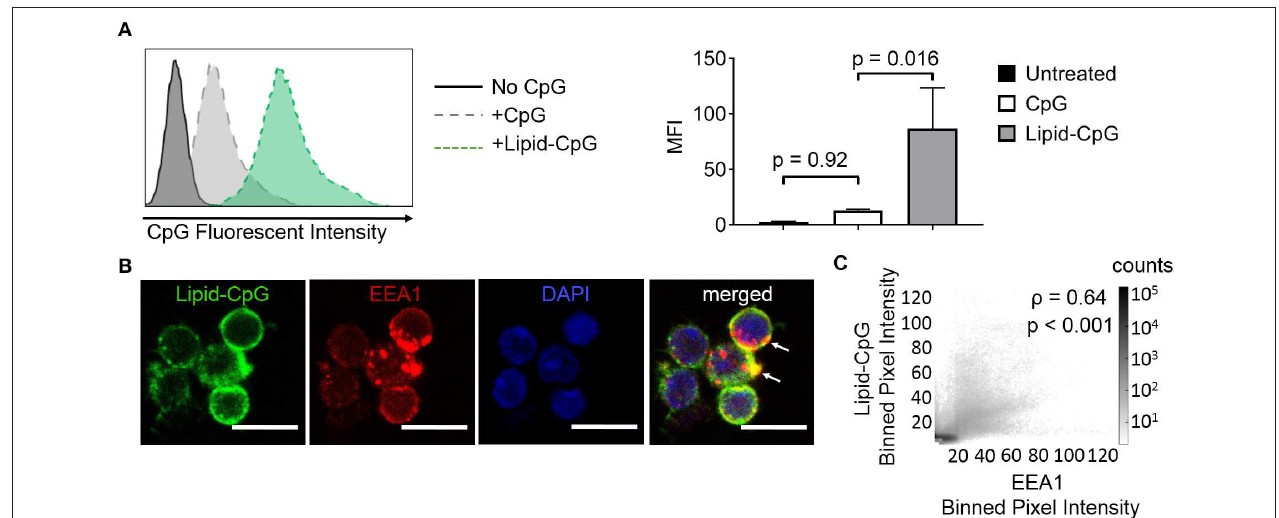
FIGURE 1 | Insertion of TLR9 ligand into murine immune cells is enhanced by lipid tail. Fluorescein (FAM) labeled CpG ODN or diacyl lipid conjugated CpG ODN (lipid-CpG) were incubated with splenic immune cells at 5 µ M for 1h at 37 ◦ C in supplemented RPMI media. (A) Representative fluorescent intensity as measured by flow cytometry (left), and quantification of fluorescent intensity (right). p -values between indicated conditions were determined by one-way ANOVA with Sidak’s method for multiple comparisons correction. Data showed m ± s.d. ( n = 3 independent samples). (B) Confocal micrographs showed lipid-CpG delivery to cell plasma membranes and associated with early endosome marker-1 (EEA1) (white arrows). Lipid-CpG (green), EEA1 (red), DAPI (blue). Scale bar = 10 µ m. (C) Bivariate scatter plot showed binned (2x2) pixel intensities between lipid-CpG and EEA1. Pearson’s correlation coefficient was determined as ρ = 0.64 ( p < 0.001). Data compiled from n = 52 cells from 3 independent